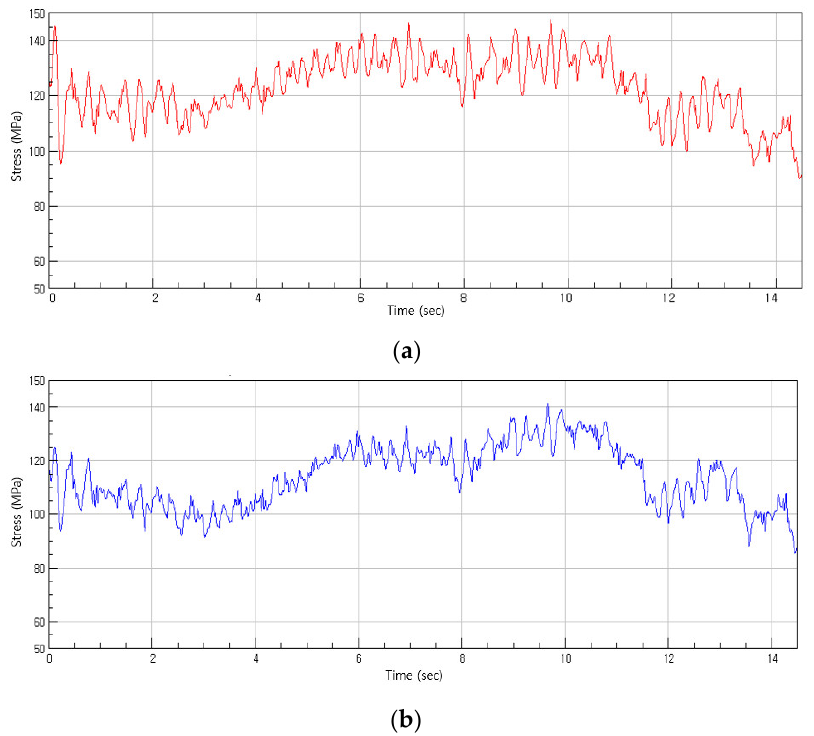
Figure 11. Measured stress at each fastening device when loading part lifted: ( a ) fastening device 1; ( b ) fastening device 2.